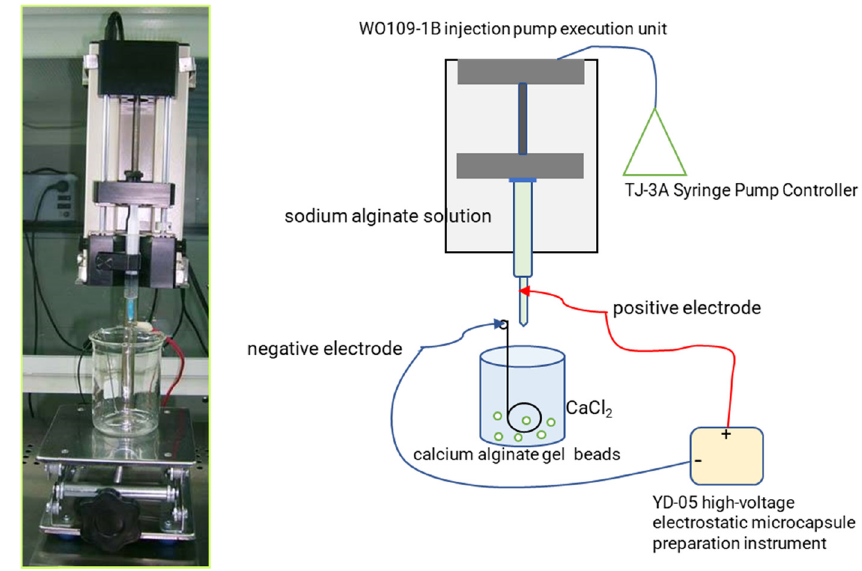
Figure 2: Principle and schematic of the preparation of calcium alginate hydrogel beads using the high - voltage electrostatic encapsulation method.